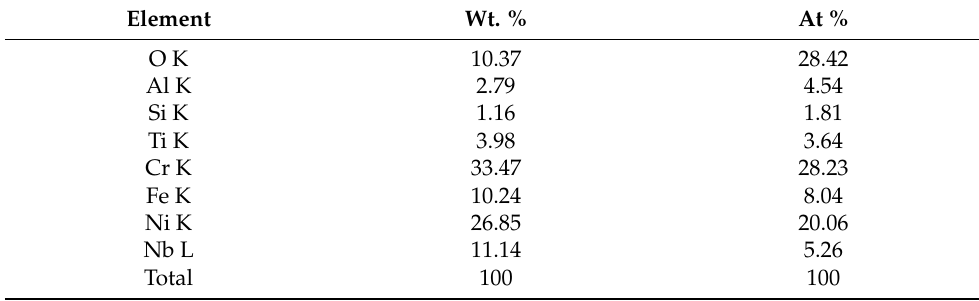
Table 4. Composition of adhered material at the measured